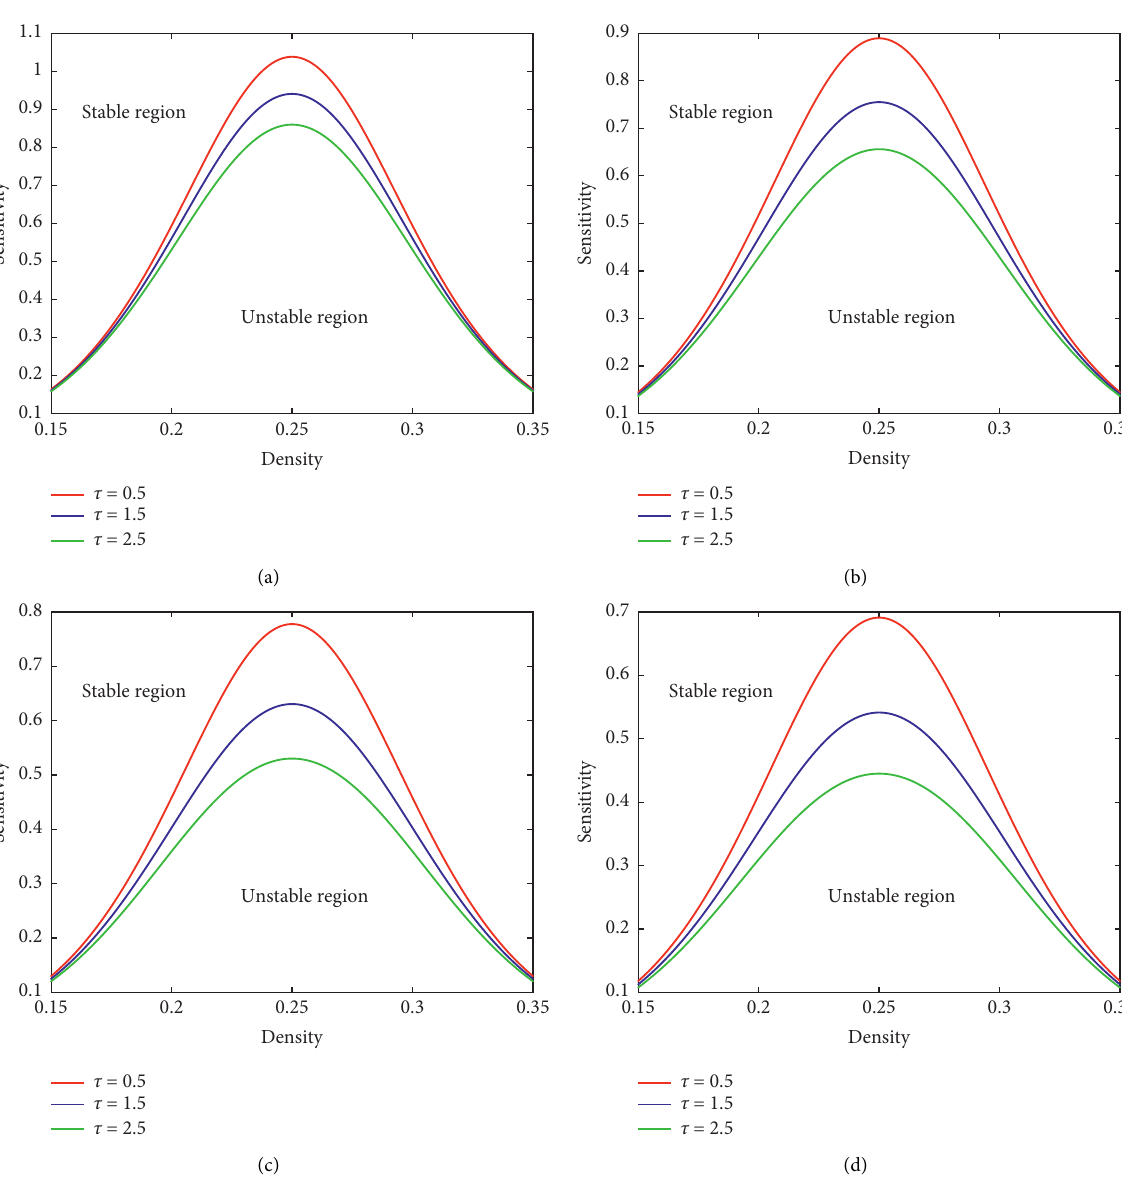
Figure 1: The neutral stability curves for c � 0 . 1 for different values of p and τ : (a) p � 0 . 1; (b) p � 0 . 2; (c) p � 0 . 3; (d) p � 0 .